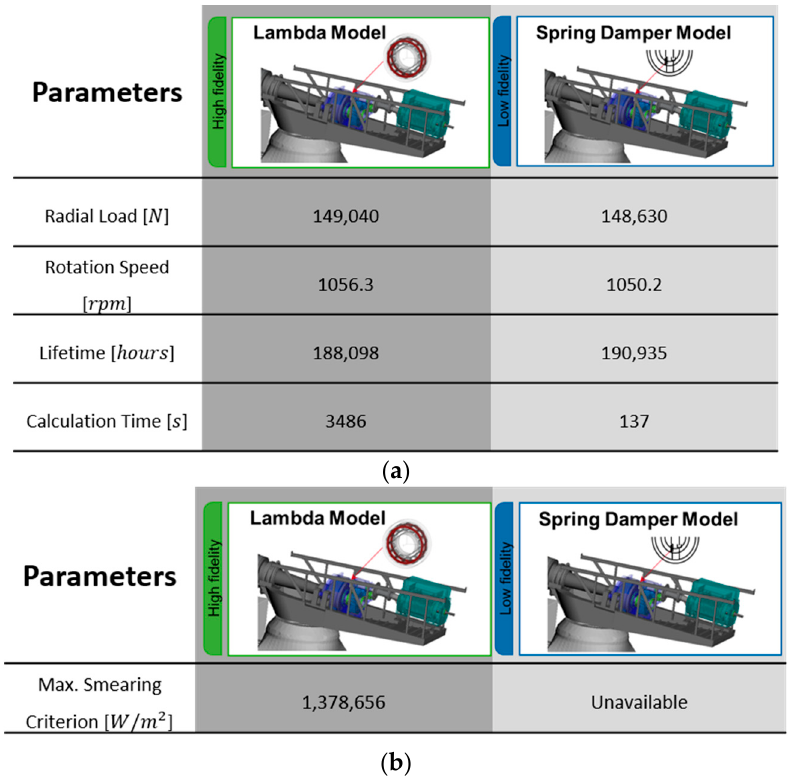
Figure 10. ( a ) Comparison of calculation results of using two fidelity MBS domain models in sce-